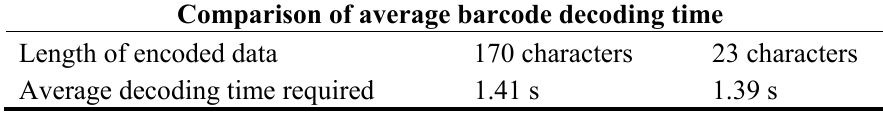
Table 3. Comparison of average barcode decoding